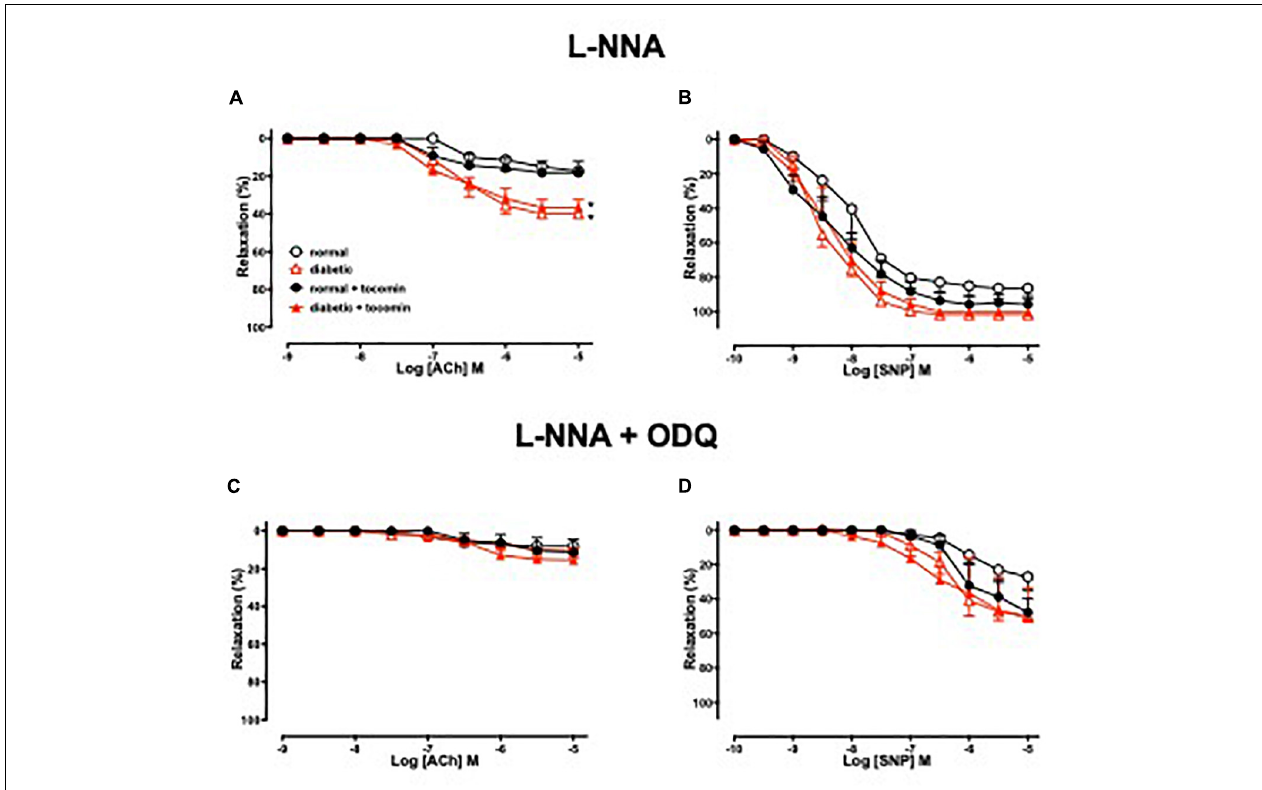
FIGURE 3 | Cumulative concentration–response curves to ACh and SNP in endothelium-intact aortae isolated from normal, diabetic, and tocomin treated (normal + tocomin/diabetic + tocomin) rats in the presence of L-NNA (A,B) and L-NNA + ODQ (C,D) . Data is expressed as mean ± SEM. ∗ p < 0.05. Sidak’s multiple comparison test. n = 4–8. See Table 2 for values and statistical